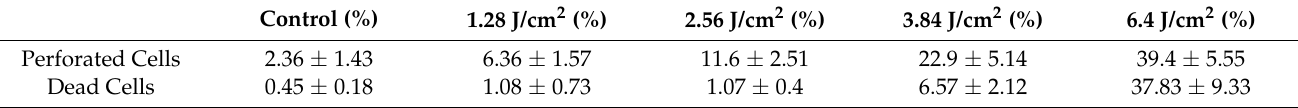
Figure 4. ( a ) The TEM photograph and a graph (insert graph) with size distribution of AuNPs from TEM images. ( b ) SEM images of HeLa cells without incubation with AuNPs. ( c ) SEM images of HeLa cells incubated with naked AuNPs (60 nm) and an incubation time of 1 h. ( d ) SEM images of HeLa cells incubated with antibody-modified AuNPs at an incubation time of 0.5 h; ( e , f ) are the zoomed-in images. Table 2. Statistical results for perforated and dead